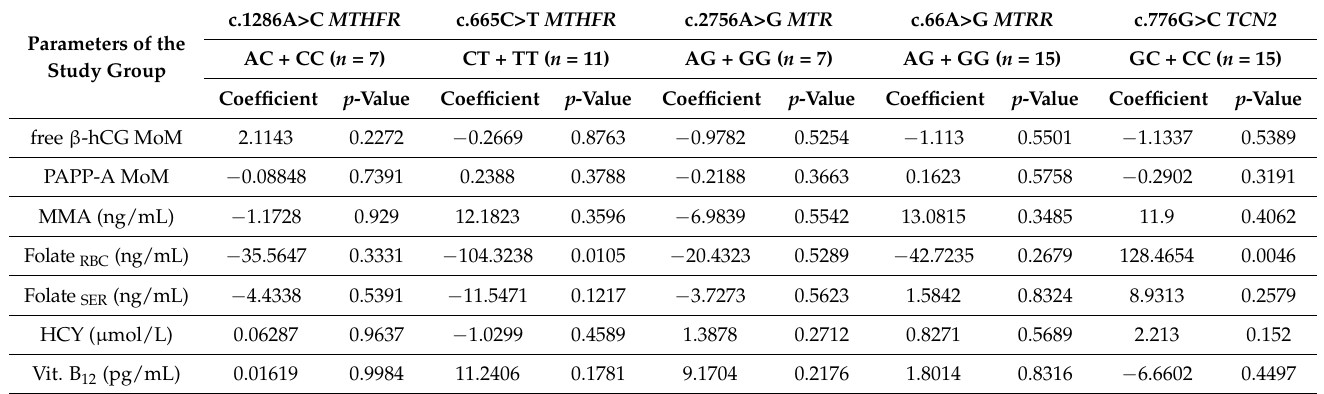
Table 5. Assessment of the relationship between the occurrence of alternative genotype variants in both hetero- and homozygous systems with the concentrations of the tested biochemical parameters in the study group based on a multivariate regression model analysis.